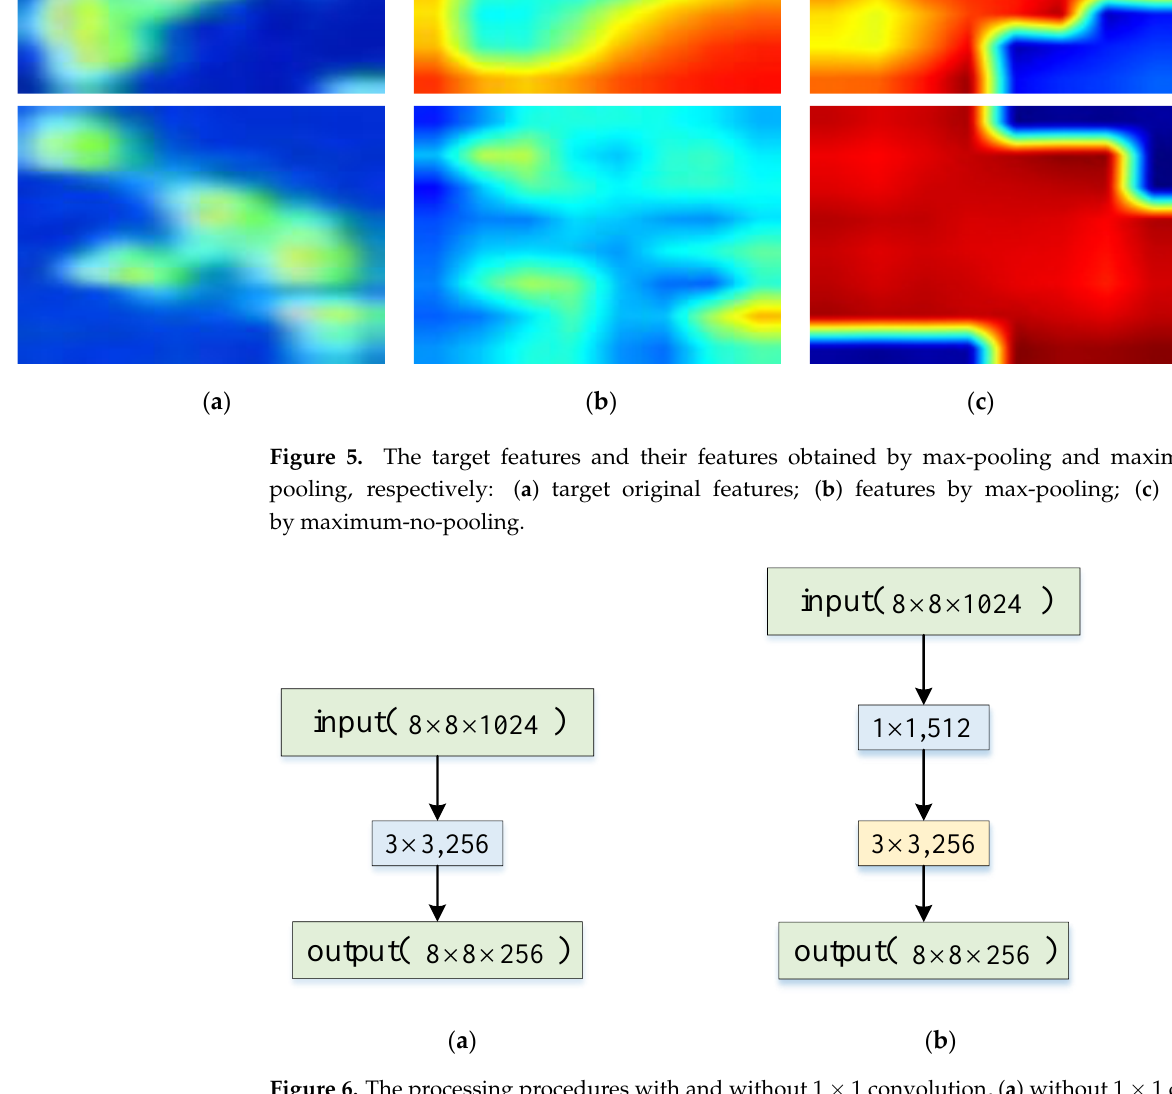
Figure 6. The processing procedures with and without 1 × 1 convolution, ( a ) without 1 × 1 convolution; ( b ) with 1 × 1